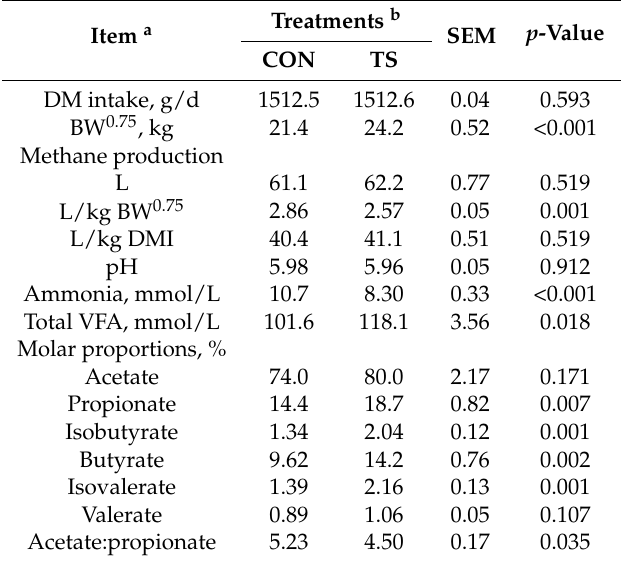
Table 4. Effects of tea saponin (TS) supplementation on daily methane production and ruminal fermentation in ewes. Item a